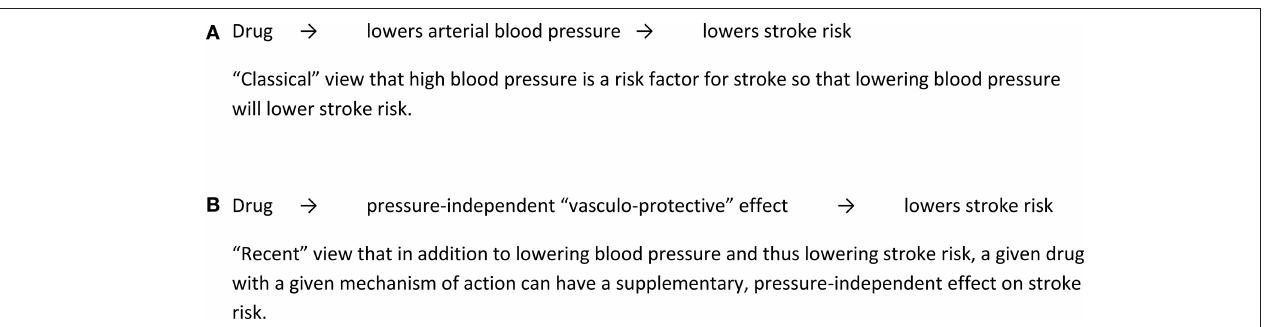
FIgure 1 | Possible pressure-dependent (A) and pressure-independent (B) effects of antihypertensive drugs on the cerebral circulation and